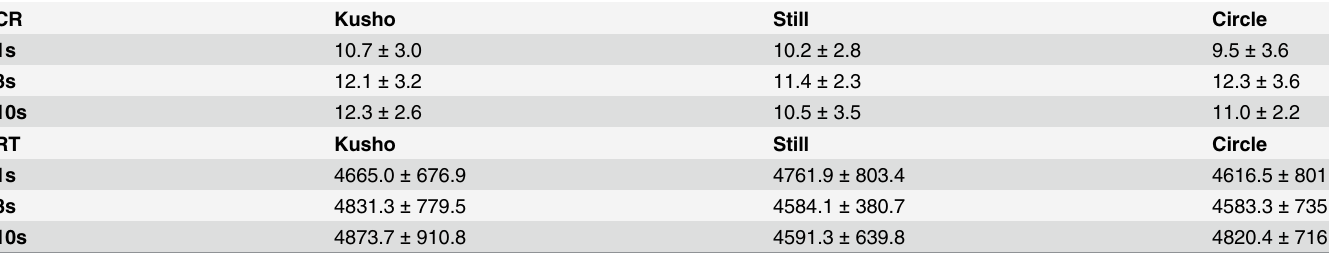
Table 2. Number of correct response and Response time (ms) in the simultaneous presentation